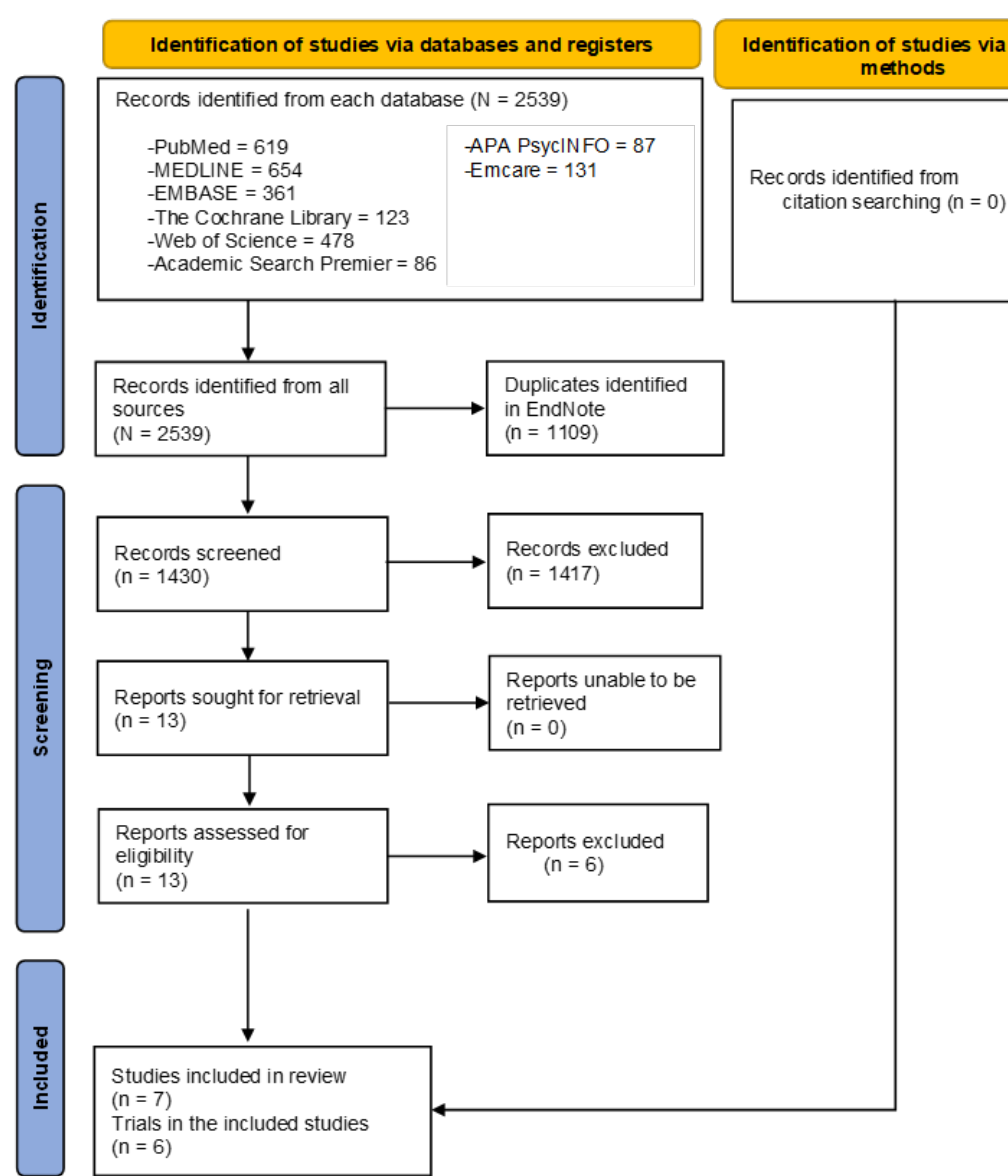
Figure 1. PRISMA study flowchart.